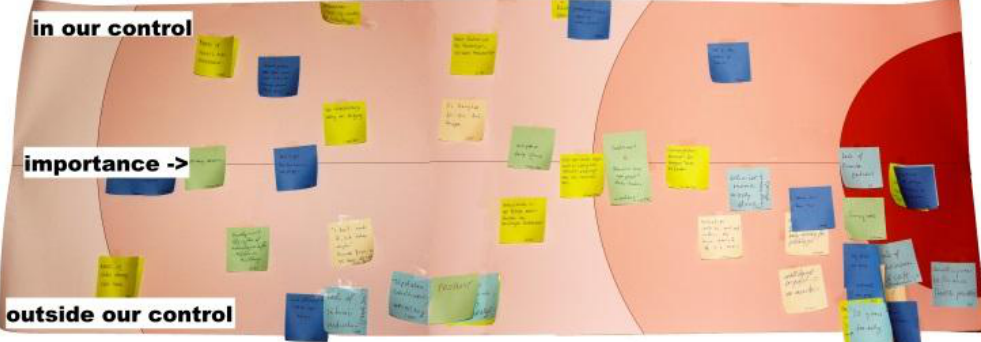
Figure 3. Rating from workshop 2. The issues above the line are “in our control”; the issues to the right in the darker areas are rated more